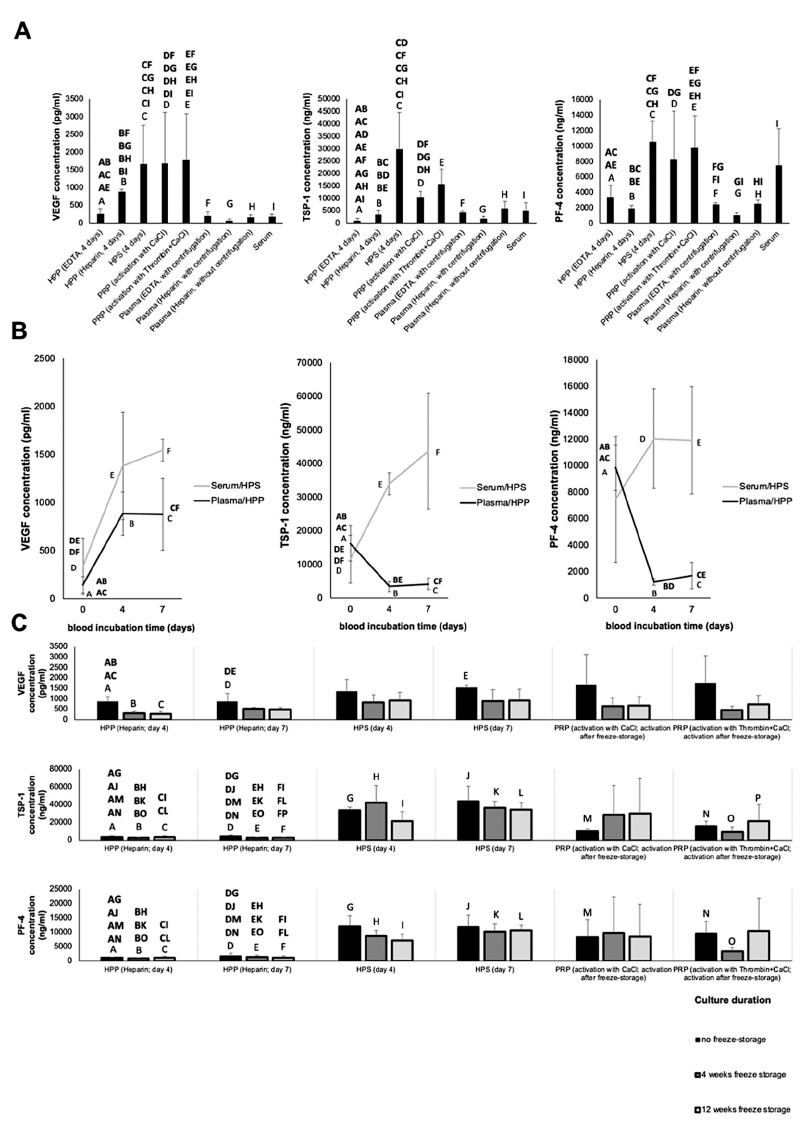
Figure 2. Quantitative analysis of pro- (VEGF) and anti-angiogenic (TSP-1, PF-4) factor concentration in blood-derived secretomes. ( A ) Plot showing the concentration of VEGF (pg/mL); TSP-1 (ng/mL) and PF-4 (ng/mL) in the various blood-derived secretomes tested ( n = 5). Note that HPP and HPS were prepared without centrifugation. EDTA and heparin were used as blood anticoagulants in HPP and plasma preparation. ( B ) Effect of blood incubation time (days) on pro- (VEGF) and anti- (TSP-1, PF-4) angiogenic factor concentration in hypoxia preconditioned secretomes over 4 and 7 days preconditioning ( n = 5). ( C ) E ff ect of freeze-storage on factor bioavailability. Plots comparing the VEGF, TSP-1 and PF-4 concentrations in fresh blood-derived secretomes and in secretomes stored for 4 and 12 weeks at − 20 ◦ C before testing ( n = 5). Capital letter pairs over plots indicate statistical comparison of corresponding data points. For all pair comparisons, p < 0.05, unless otherwise indicated. Error bars represent